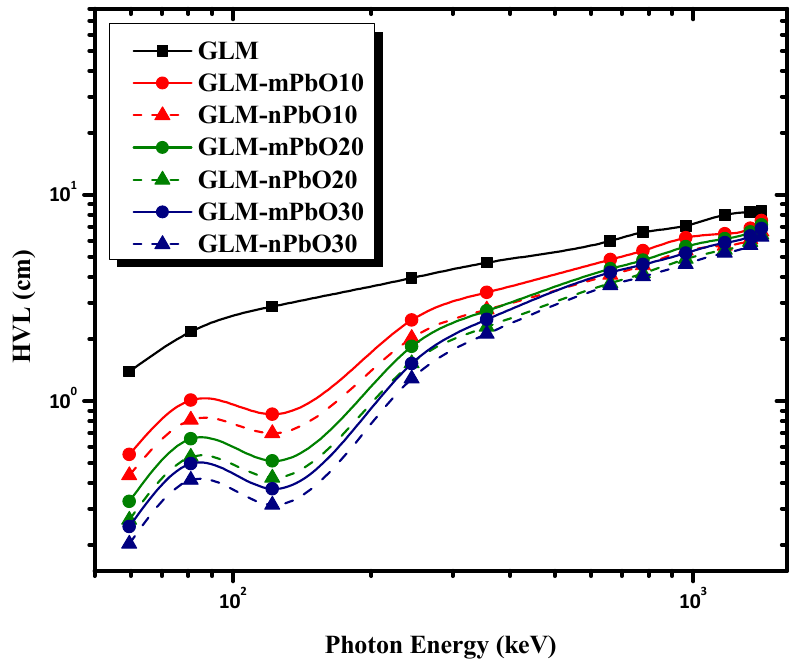
Figure 5. The variation of HVL as a function of photon energy for micro- and nano-PbO mortars.